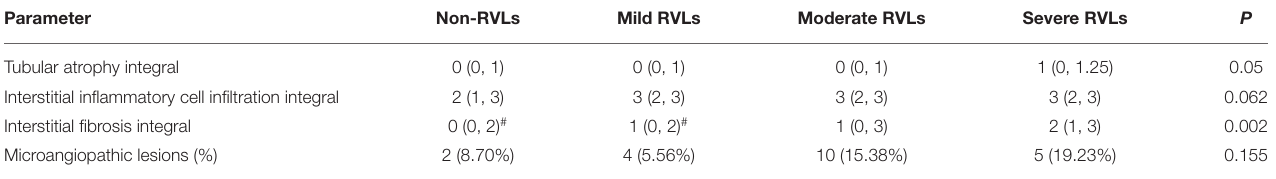
TABLE 4 | Pathologic variables of renal tubulointerstitial tissue of the non-RVL, mild RVL, moderate RVL, and severe RVL groups.